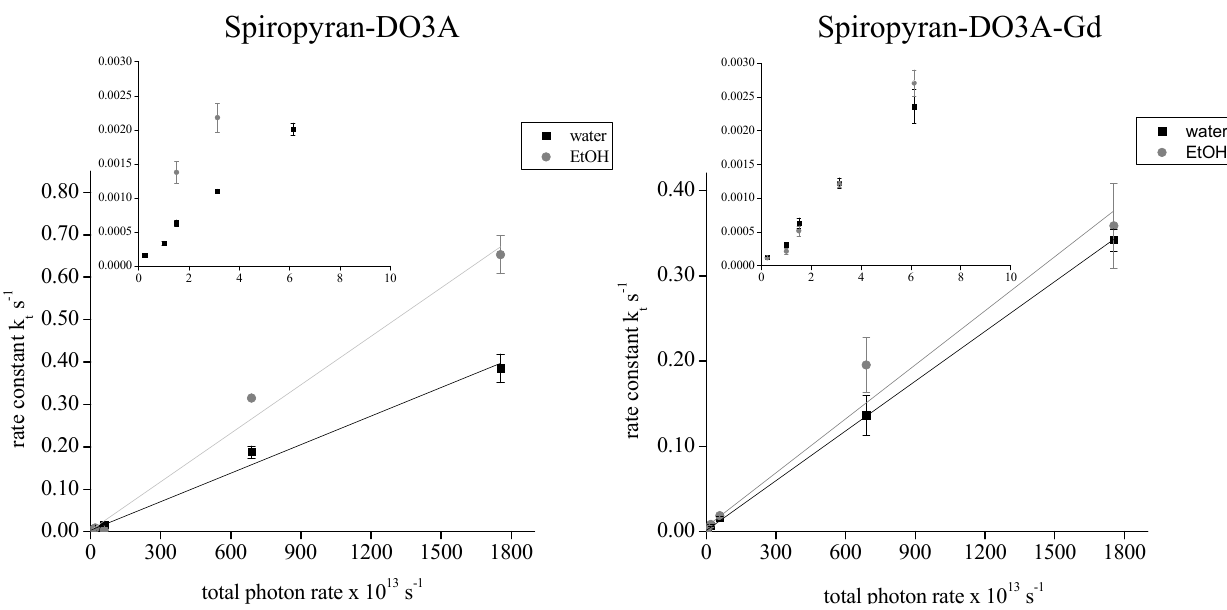
Figure 2. Determination of rate constants and maximum MC to SP conversion in relation to the total photon emission rate: The rate constants of spiropyran-DO3A-Gd, dissolved in water and ethanol were determined after illumination with the blue LED using equation (2). The insert displays the data points between 0 s − 1 and 10 × 10 13 s − 1 . A linear regression analysis was performed which gave R 2 = 0.99156 for spiropyran-DO3A dissolved in water and R 2 = 0.98982 for spiropyran-DO3A dissolved in ethanol. For spiropyran-DO3A-Gd dissolved in water the regression analysis gave R 2 = 0.99978 and R 2 = 0.97866 for spiropyran-DO3A-Gd dissolved in